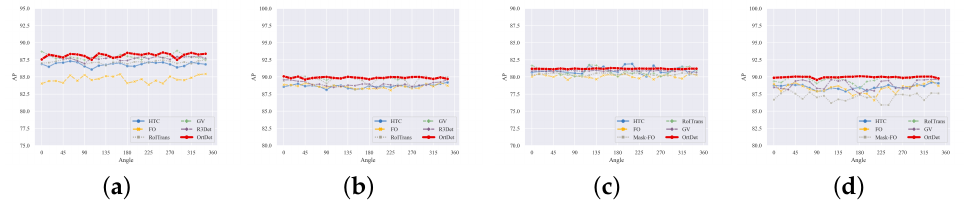
Figure 9. ( a , b ) show the fluctuation of the detection accuracy of the ship and plane categories in the DOTA-V1.0 dataset with the rotation angle of the dataset, respectively. ( c , d ) show the fluctuation of the detection accuracy of the ship and plane categories in the DOTA-V1.5 dataset with the rotation angle of the dataset, respectively.